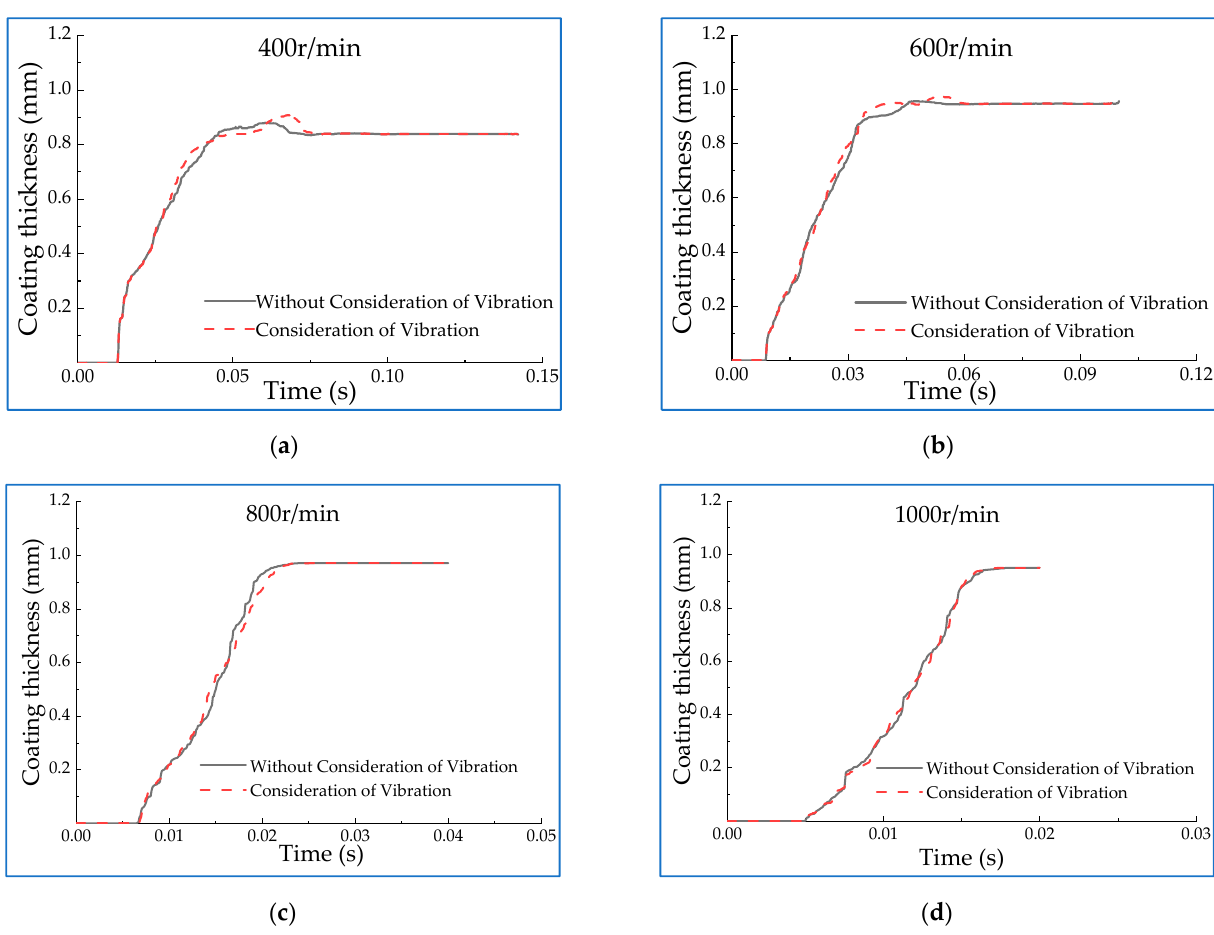
Figure 7. Contrast diagram of coating thickness affected by vibration.